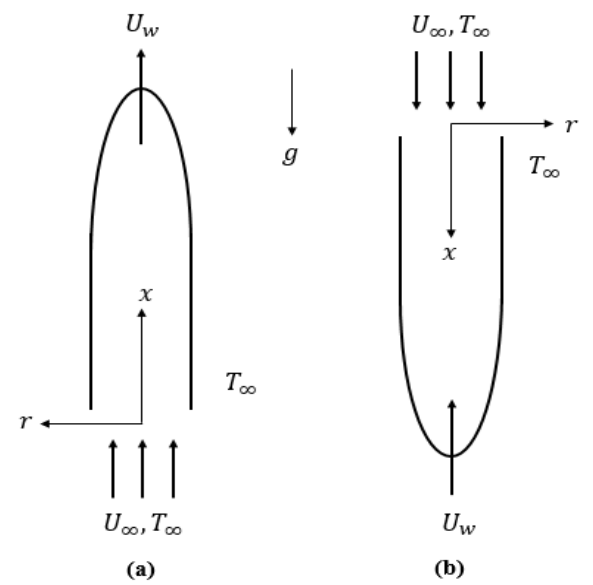
Figure 1. Physical models and coordinate systems: ( a ) assisting flow and ( b ) opposing